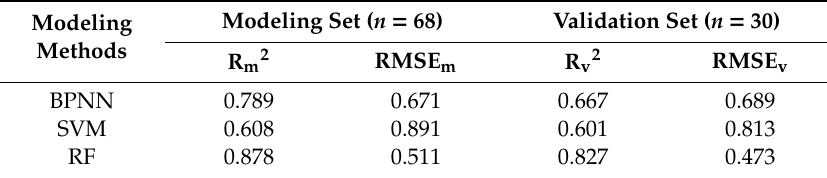
Table 3. Accuracy of three inversion models based on UAV images.